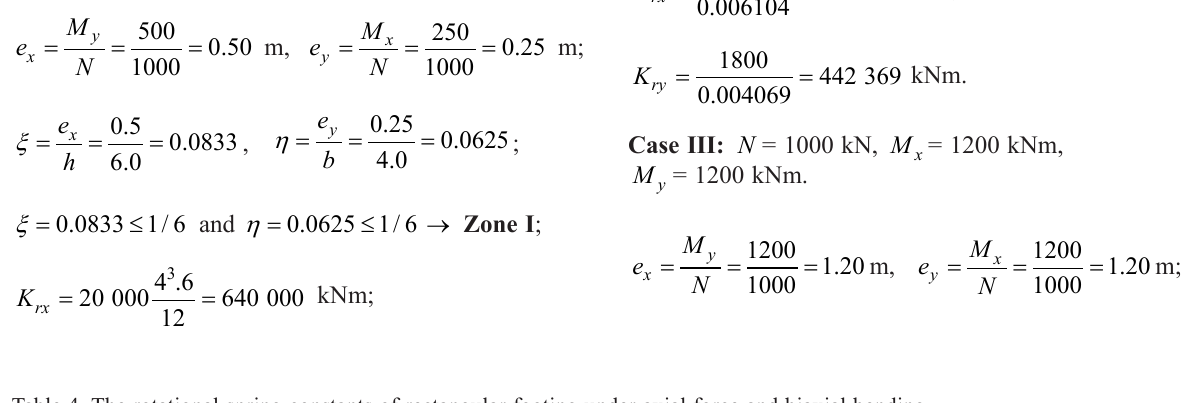
Table 4. The rotational spring constants of rectangular footing under axial force and biaxial